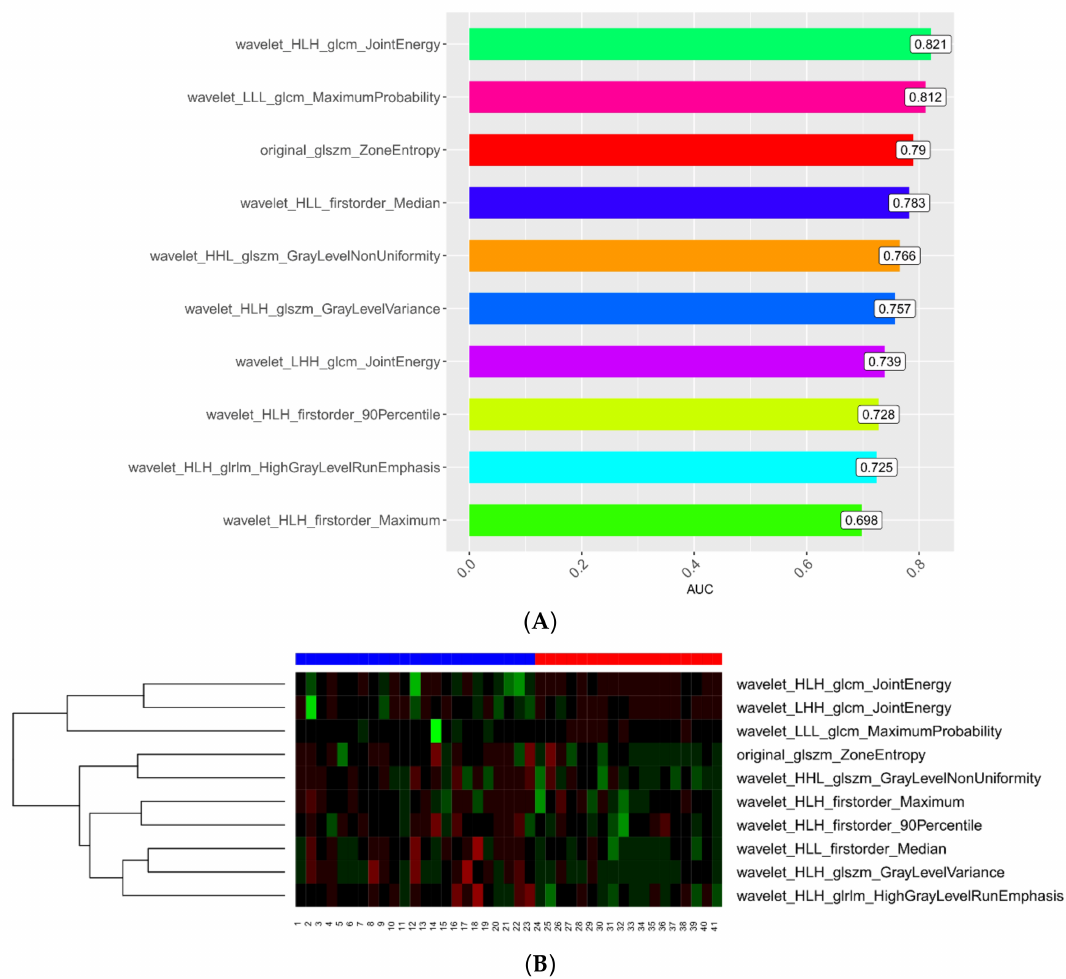
Figure 3. ( A ) AUC barplot showing AUCs of the features used in the first model. ( B ) The 10 feature parameters and corresponding coefficients after screening in the first model are shown in a